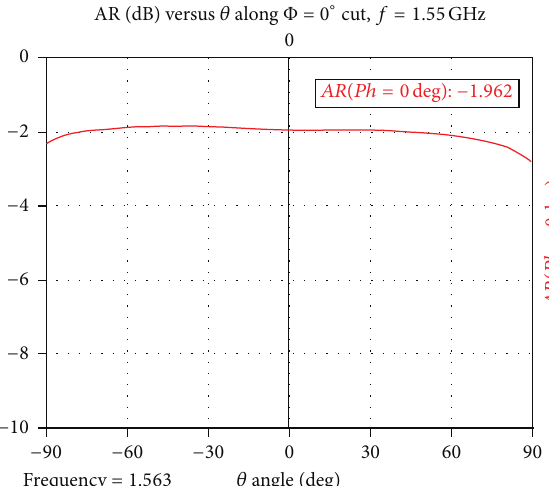
Figure 8: Single element axial ratio versus elevation angle.